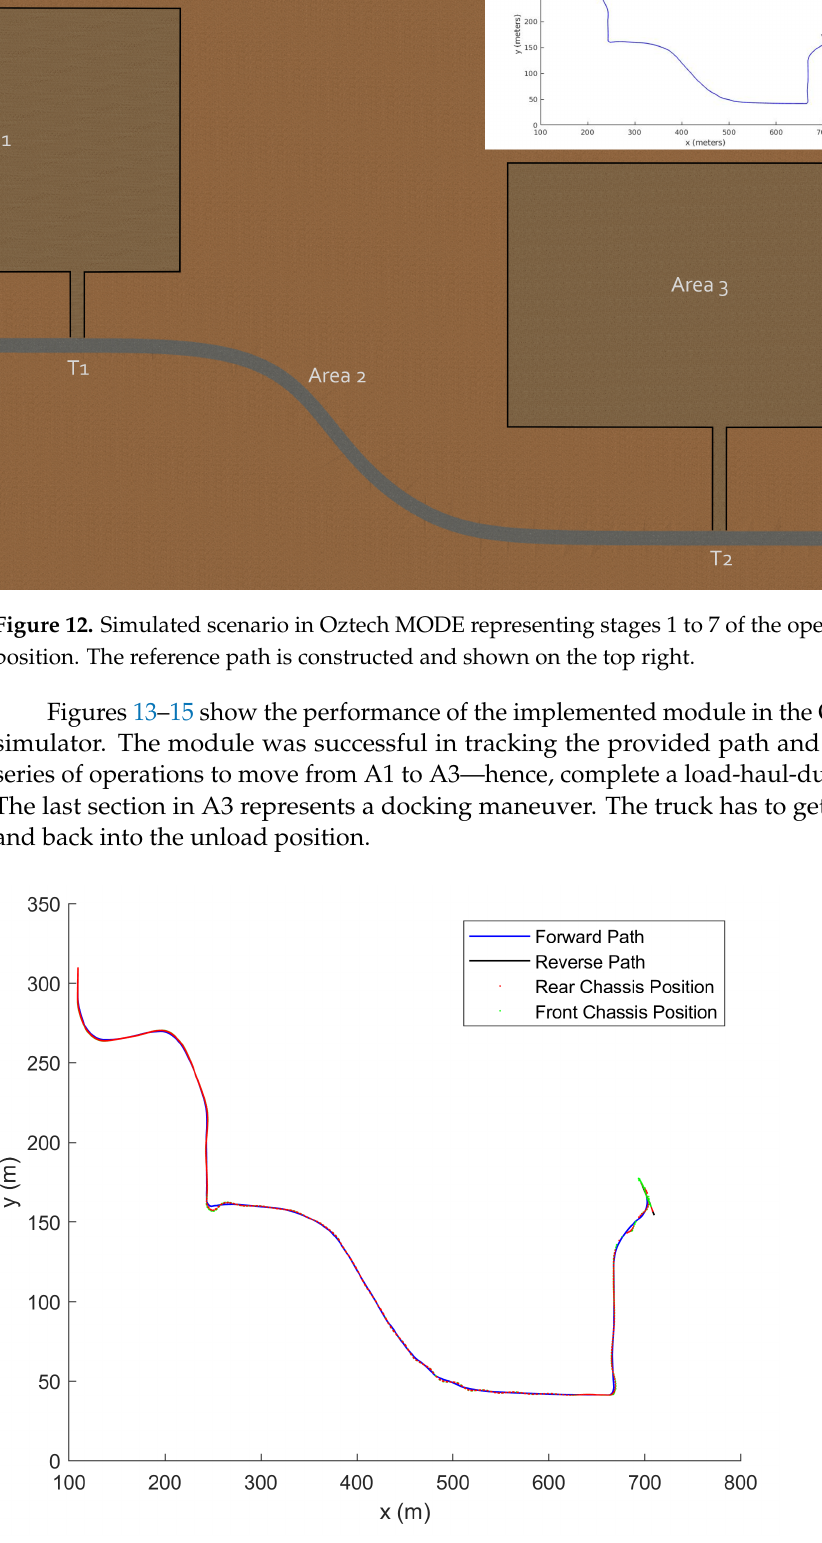
Figure 13. Path tracking performance of the FSM and Path Tracking module in operating from A1 (load) to A3 (dock and